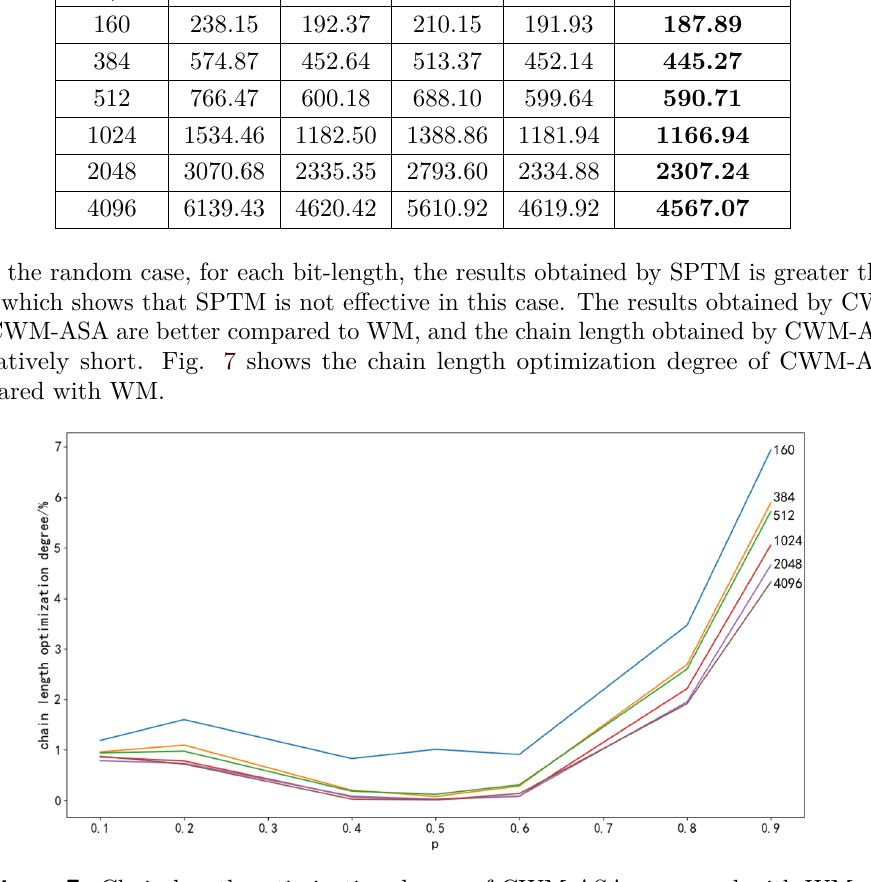
Figure 7: Chain length optimization degree of CWM-ASA compared with